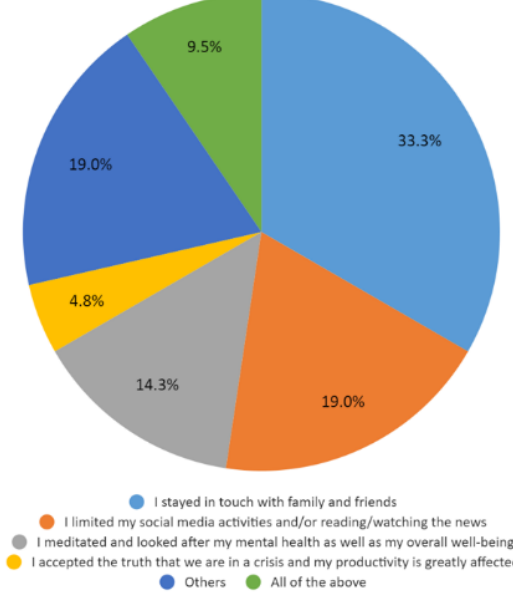
Figure 9 . Survey responses from the short survey about coping with the pandemic. (Kindly note that these results are not representative of the